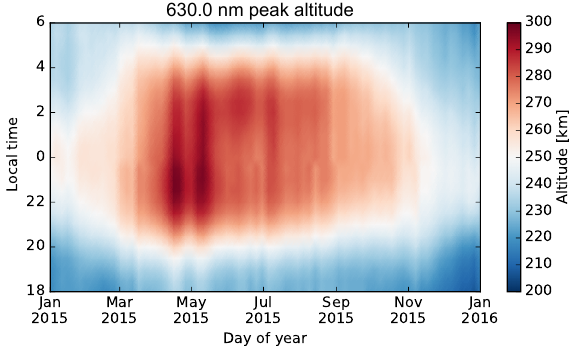
Figure 6. Modeled 630.0nm emission peak altitude over Oukaïme- den Observatory as a function of local time and day of year during 2015. The emission profile was modeled using the volume emission rate described in Link and Cogger (1988), which requires utilizing the IRI and MSIS